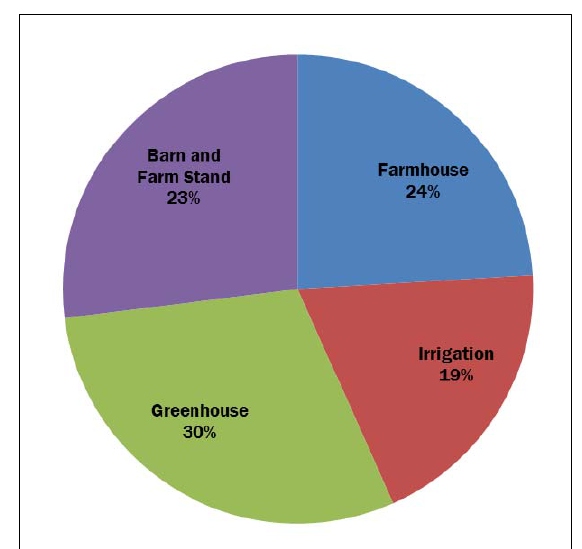
Figure 1. Farm Energy Use by